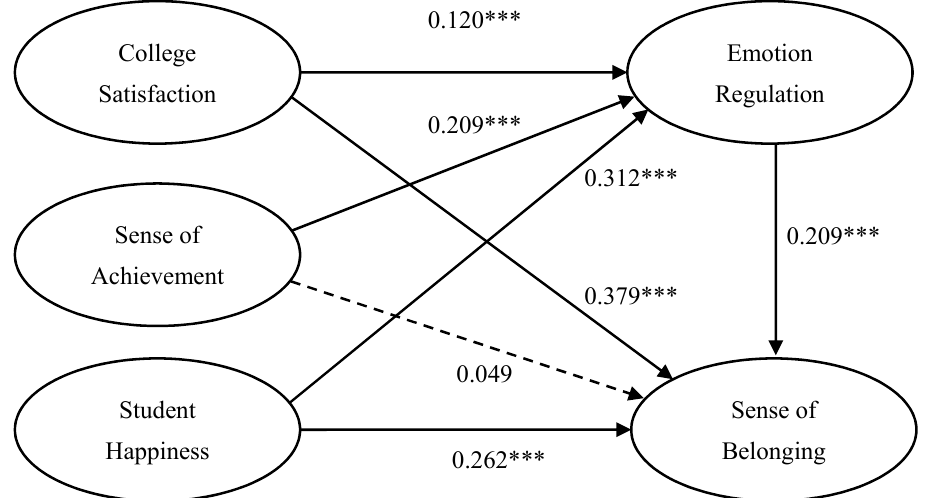
Figure 2. Structural model of relationships among College Satisfaction, Sense of Achievement, Student Happiness, emotion regulation, and sense of belonging. Dashed line signifies non-significant paths ( p > 0.05). *** p <